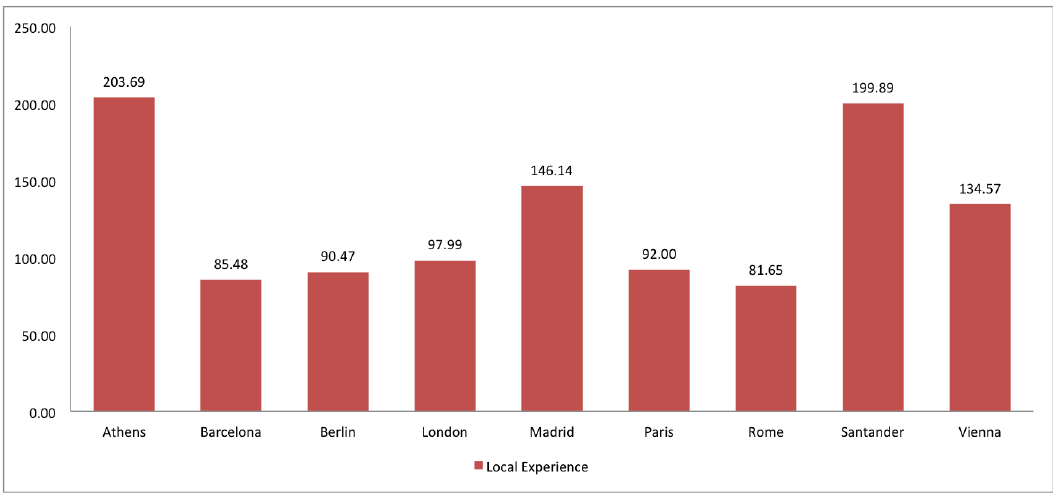
Figure 29. Trust study in Europe: local experience. Average number of contributions in the study area by contributor.